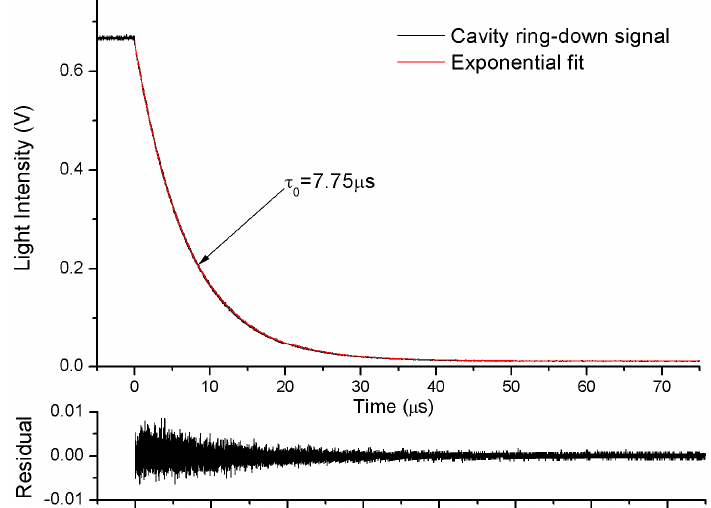
Figure 2. Typical cavity ring-down signals. The fitting residuals are shown in the lower panel. At 1531.6 nm the ring-down time was measured as τ 0 = 7.75 µs with dry N 2 flowing through the V-cavity, corresponding to a cavity finesse of 14,610 (effective absorption path length of 2.325 km). When the absorption loss of single-pass is small enough ( α L << 1 ) , the equivalent reflectivity ( R ) can be determined with the empty cavity ring-down time ( τ 0 ):